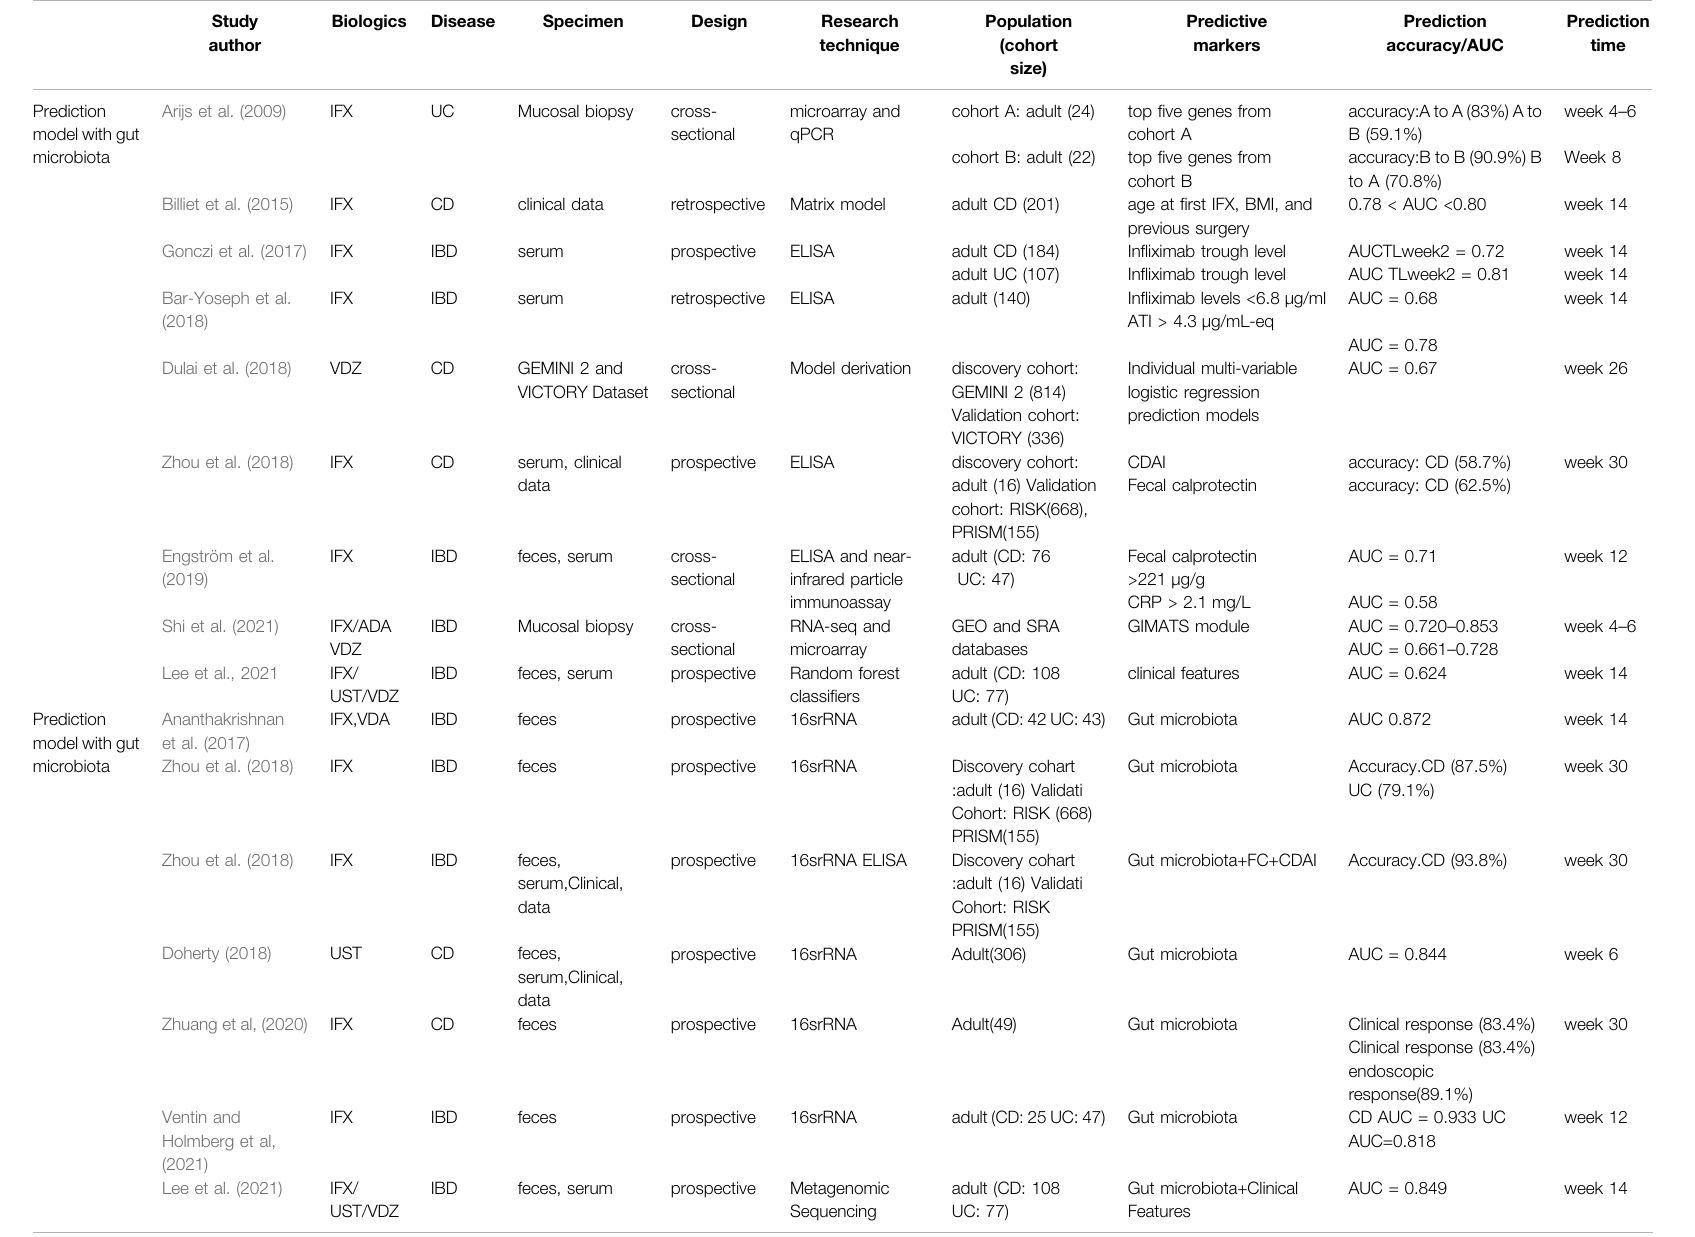
TABLE 1 | Comparison of predictive effects of different prediction models with or without gut